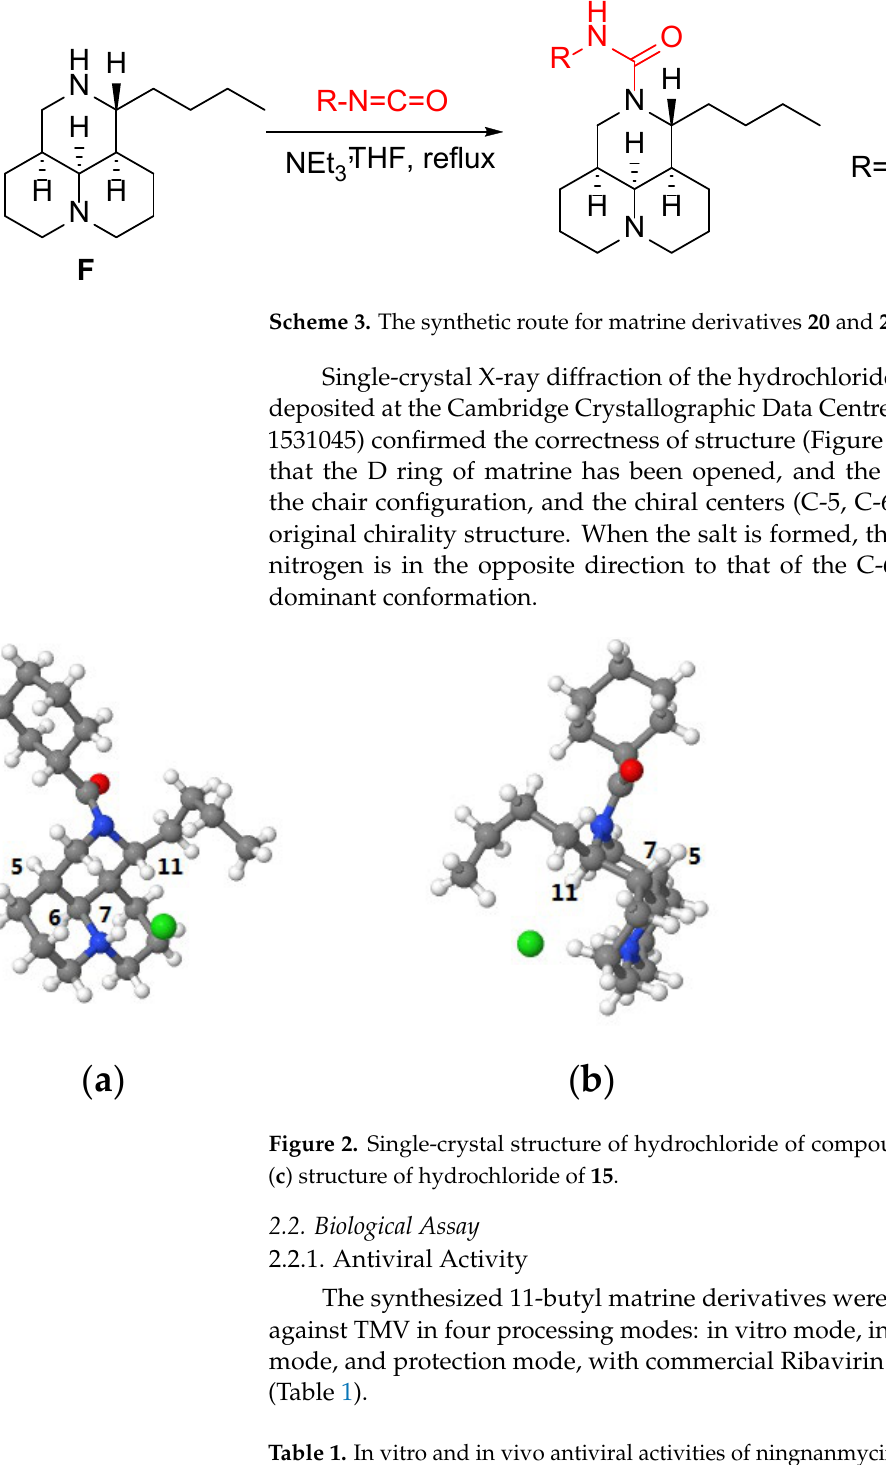
Table 1. In vitro and in vivo antiviral activities of ningnanmycin, ribavirin, matrine, and compounds 1 – 21 against TMV.